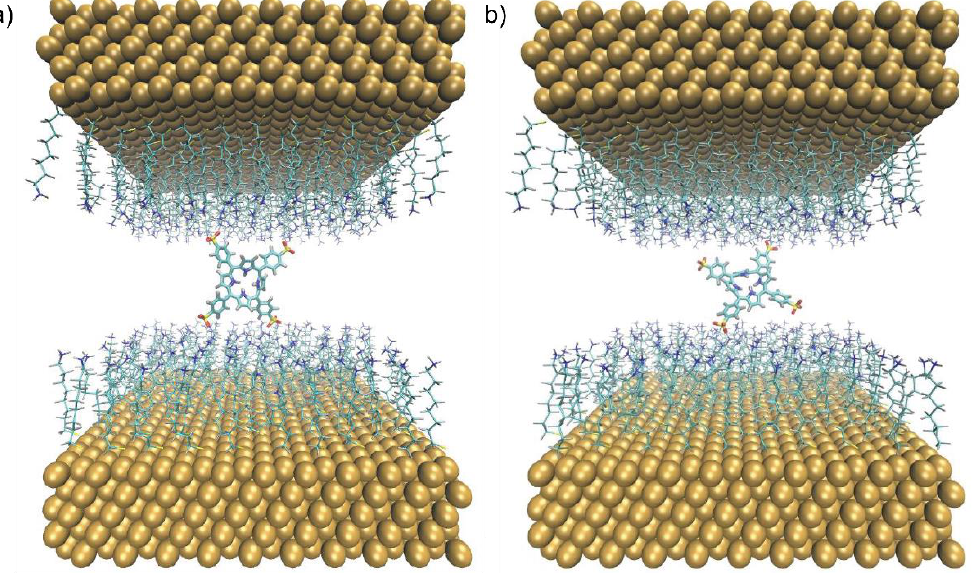
Figure 6. The central structures of two representative clusters, obtained from the simulations of a dye molecule initially laid above the capped surface at the bottom. The central structure in ( a ) was obtained from the 1 µ s trajectory with the thicker box, while in ( b ), it was from the 500 ns trajectory, with a thinner solution layer. They account for 5.5% and 31.6% of the analyzed frames in the corresponding trajectories.